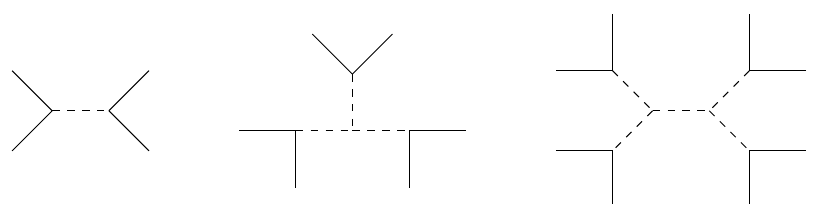
Figure 3 . A series of EFT operators with more powers of fields generated by insertions of the self trilinear coupling in the s -channel model. Dashed lines denote the heavy scalar mediator S ; solid lines denote light particles, either scalar quarks or the BSM singlet scalars φ